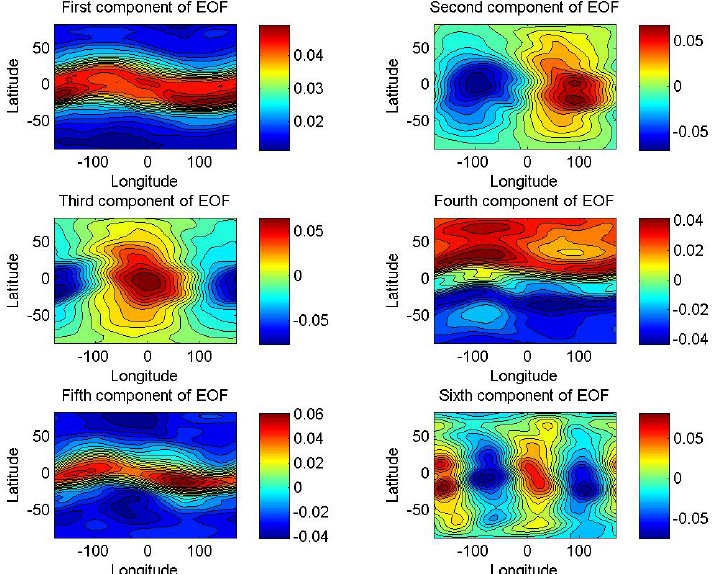
Figure 8. First six EOFs for the 11-year global TEC as functions of longitude and geographic latitude calculated by the spatial and temporal settings given in Fig.